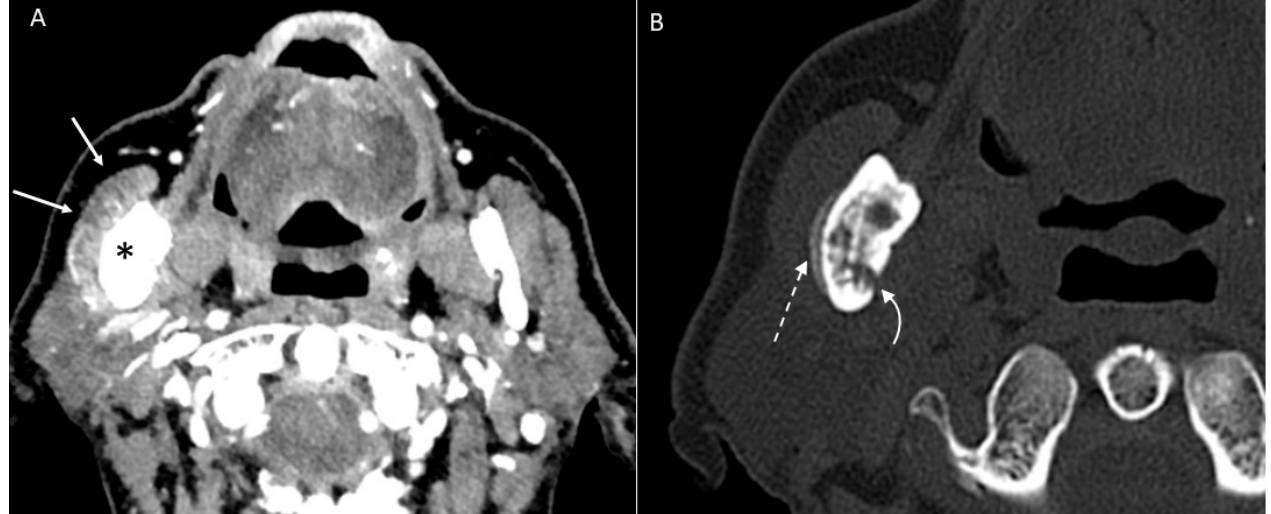
Figure 3. Soft tissue vs. bone kernel. ( A ) Axial contrast-enhanced soft tissue CT kernel and ( B ) axial bone CT kernel of the same patient with osteomyelitis of the right lower jaw with inflammation of the surrounding soft tissues. In ( A ) the swelling and hypervascularisation of the soft tissues (arrows) surrounding the right lower jaw (*) can be appreciated (see contralateral side for comparison). The bone structures are not evaluable. In ( B ) a periosteal reaction (dotted arrow) and focal interruption of the cortical profile can be appreciated (curved arrow).